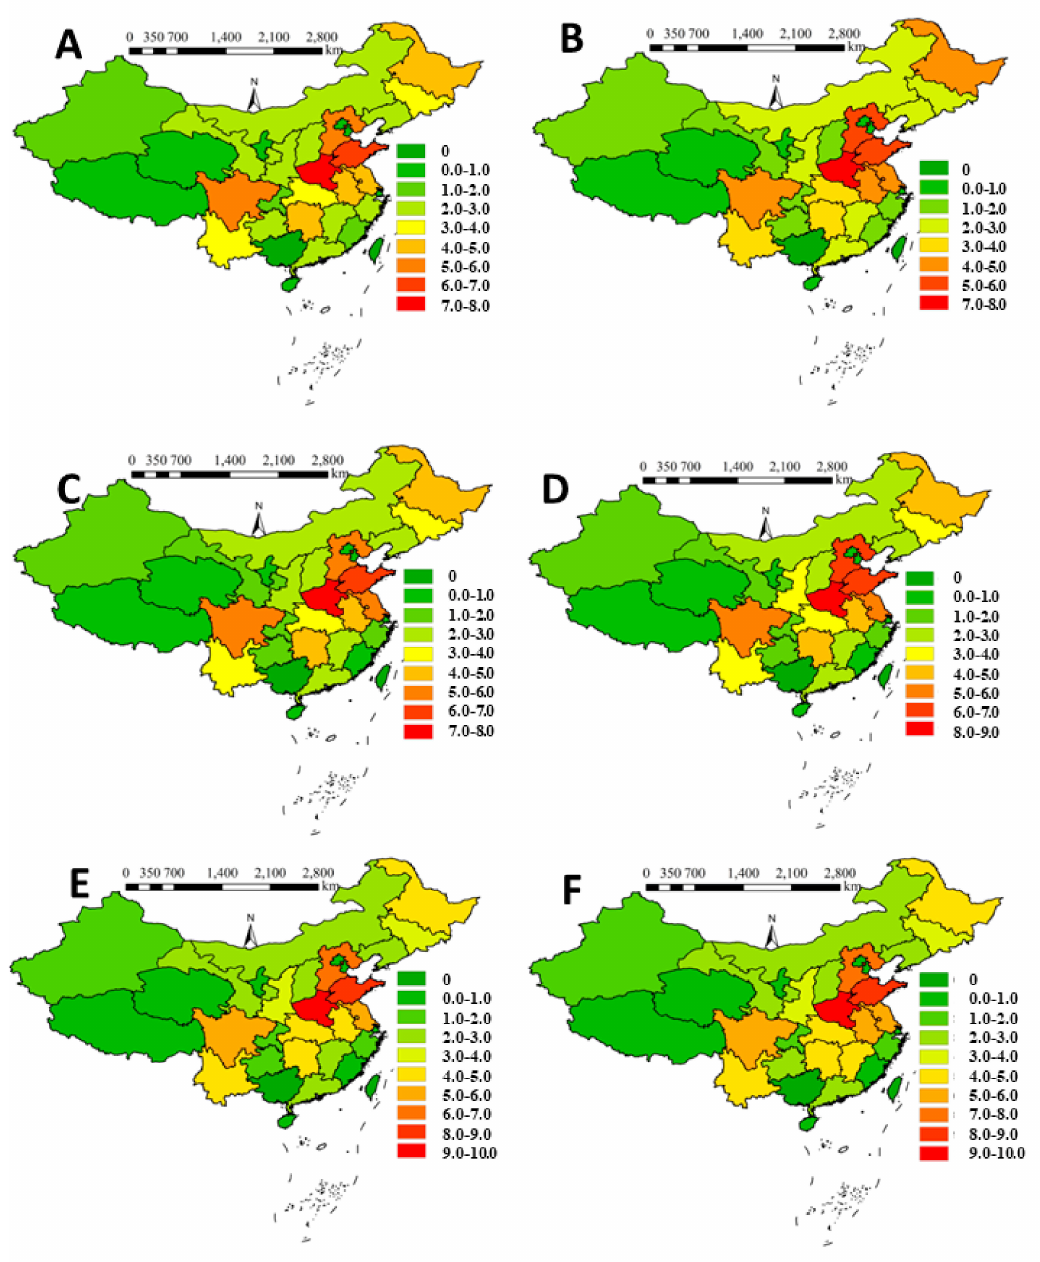
Figure 2. The spatial variation in the cereal cultivated area (M ha) in China from 1998 to 2016. Average cereal cultivated area from 1998–2001 ( A ), 2002–2004 (B), 2005–2007 ( C ), 2008–2010 ( D ), 2011–2013 ( E ), and 2014–2016 ( F